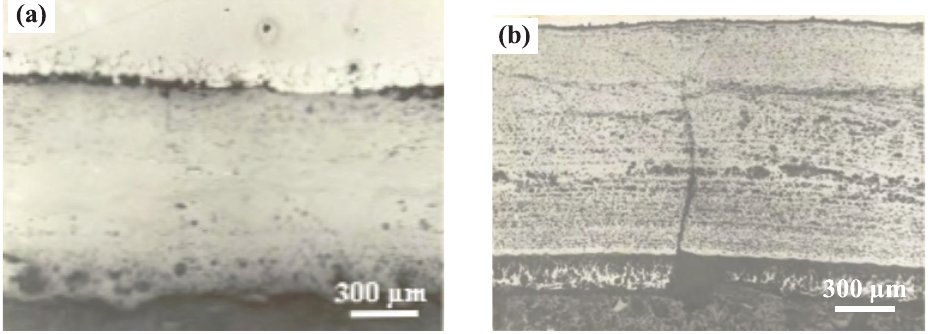
Fig. 5: Micrographs showing (a) thickness profile of fire side oxide layer in rupture zone and (b) thickness profile of steam side oxide layer in puncture zone.